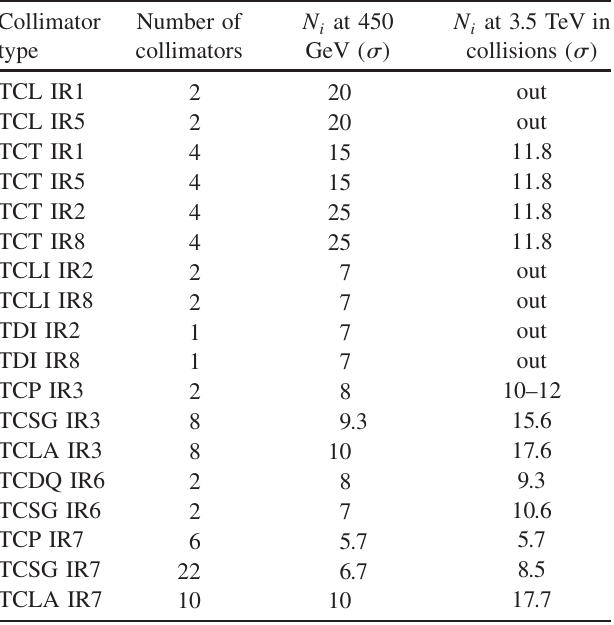
TABLE I. Operational half-gap openings N i in units of beam (cid:2) for different energies and collimator families as used in the 2011 run. These values establish a multistage cleaning and protection hierarchy in betatron and momentum phase space.